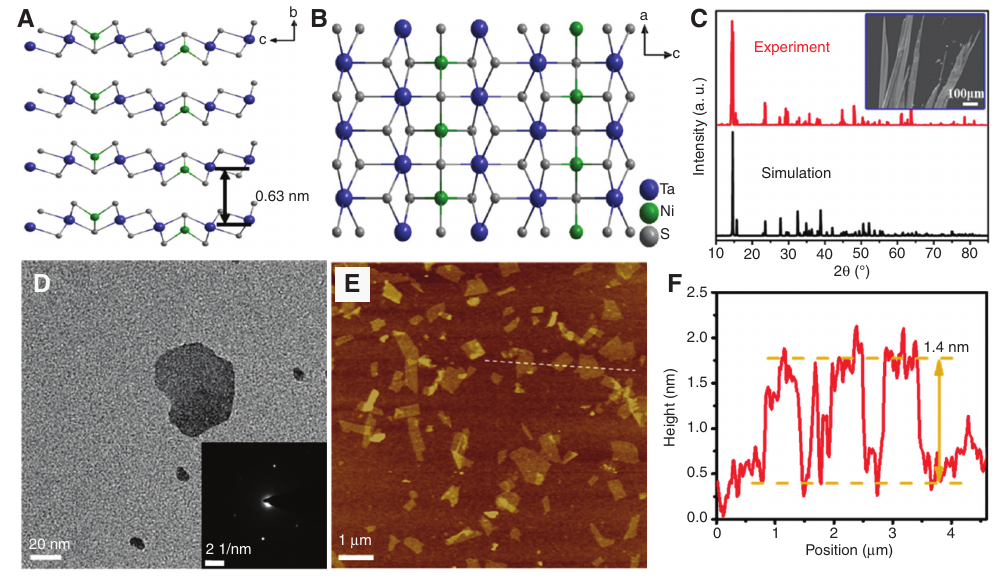
NiS . Figure 1: Characterization of Ta 2 5 Structures of Ta NiS viewed (A) from the a -axis and (B) from the b -axis. (C) XRD pattern of Ta 2 5 (D) TEM image of a typical Ta NiS nanosheet. Inset: The corresponding SAED pattern. (E) AFM image and (F) height profile along the white 2 5 imaginary line in